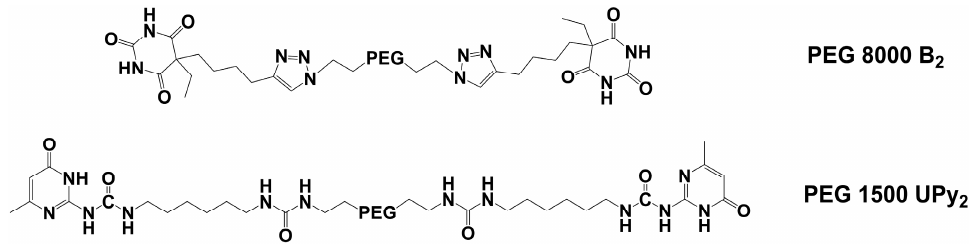
Figure 1. Chemical structures of PEG 8000 B 2 and PEG 1500 UPy 2 .